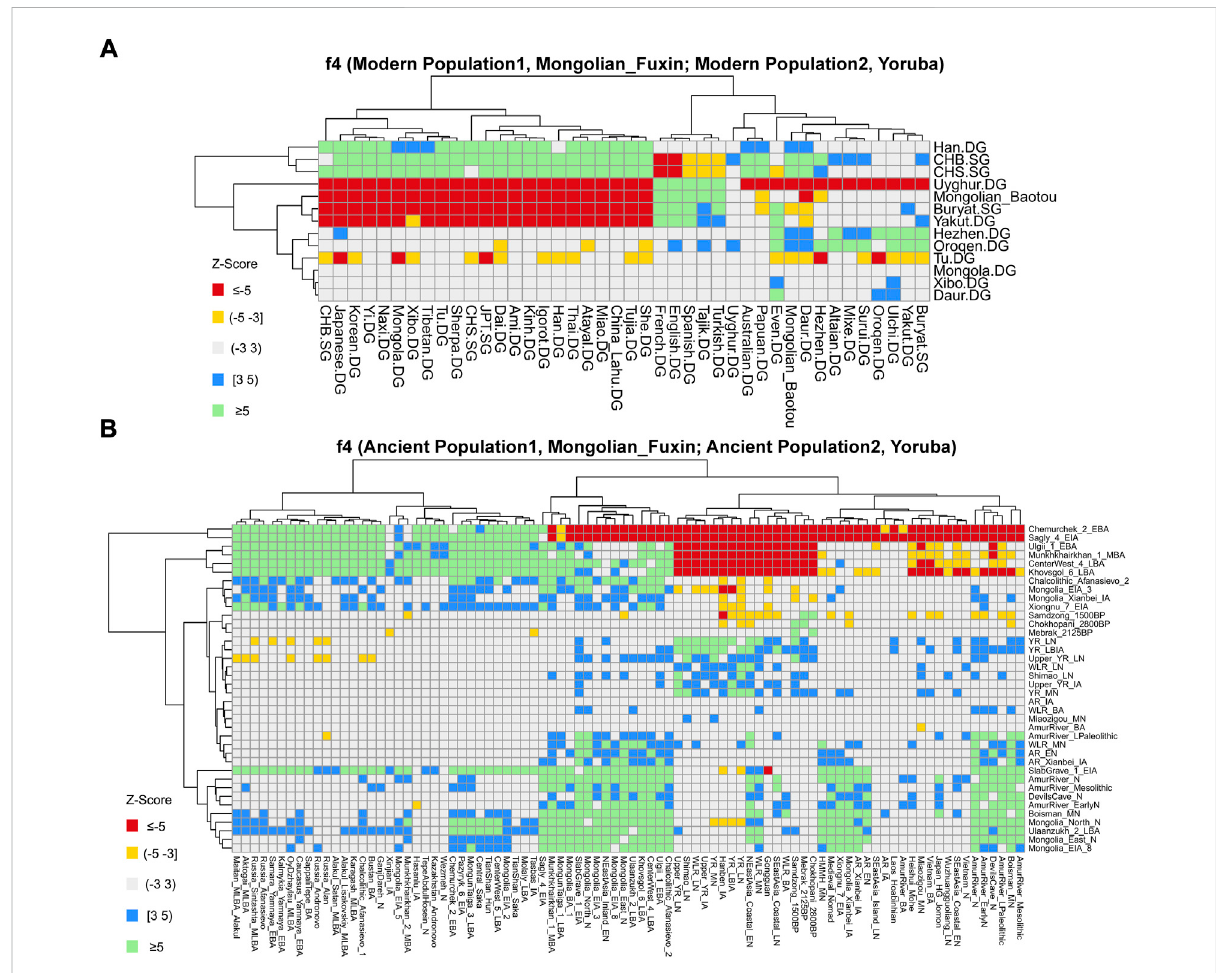
FIGURE 7 Results of f 4 -statistics performed in the form of (A) f 4 (Modern Population1, Mongolian_Fuxin; Modern Population2, Yoruba); (B) f 4 (Ancient Population1, Mongolian_Fuxin; Ancient Population2, Yoruba) exhibited the genetic af fi nity between Fuxin Mongolians and possible ancestral